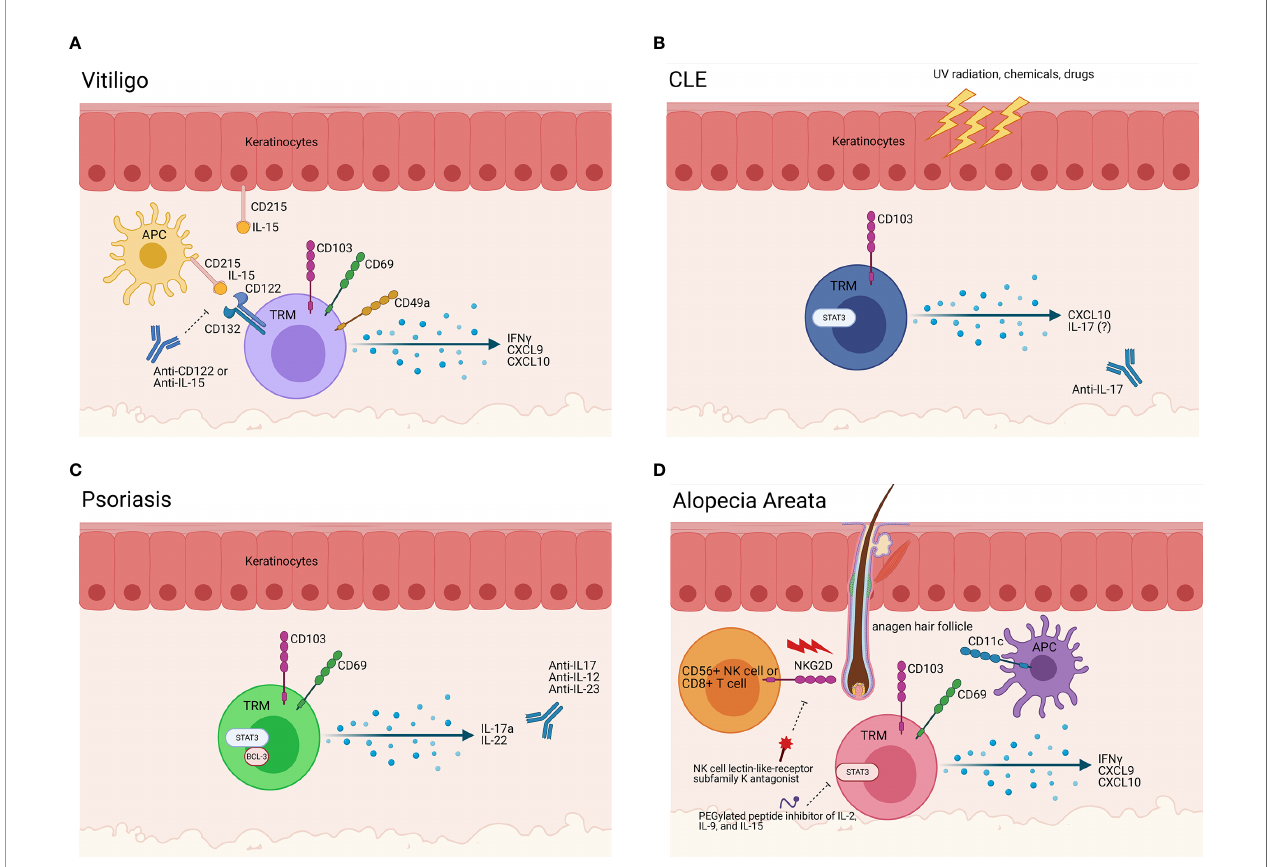
FIGURE 2 | Evidence of TRM in autoimmune skin disease. (A) TRM in vitiligo. Melanocyte-speci fi c TRM are present in vitiligo lesional skin. These cells express CD49a, CD69, CD103, and CD122 and produce IFN g and chemokines upon encountering cognate antigen, such as gp100/Pmel-17, melan-A/MART-1, tyrosinase and/or tyrosinase-related proteins 1 & 2 presented on HLA-A2. Antigen-presenting cells (APCs) and keratinocytes also play a role in vitiligo immunopathogenesis, as they release cytokines in response to a myriad of stimuli and stressors. APCs produce IL-15 and trans-present it on CD215 to T cells, which bear the CD122 and CD132 chains of the IL-15 receptor. In vitiligo, our data support that TRM act as sentinel/alarm cells to induce recall responses against melanocytes. Blocking CD122 deprives the TRM of the IL-15 survival signal, thereby inhibiting their function and/or reducing their numbers to provide a durable treatment. A clinical trial is currently enrolling to test the potential of a commercially available anti-IL-15 antibody for vitiligo (NCT04338581). (B) TRM cells in CLE. Triggers such as UV radiation, infection, hormones, drugs and chemicals create an apoptotic and in fl ammatory environment (50). In lupus-prone individuals, antigen-presenting cells (APCs) migrate to the site of injury and ingest the cell debris and possible autoantigens. When the APCs present the autoantigens to self-reactive T cells and B cells, the autoimmune response is initiated, and disease occurs (51). Speci fi cally, CD103+ TRM cells in the skin are positively correlated to disease severity and recurrence in patients. While TRM and T cell antigen speci fi cities in lupus nephritis were recently described (52, 53), speci fi cities of skin autoreactive T cells are unknown. A trial blocking anti-IL-17 antibody for DLE is recruiting (NCT03866317). (C) TRM cells in Psoriasis. CD69+ CD103+ TRM are present in psoriasis lesions. The production of cytokines such as IL-17a, IL-22, and Bcl-3 by these TRM cells lead to aberrant keratinocyte proliferation and differentiation. A recent study described melanocyte- speci fi c T cells in psoriasis patients, though other speci fi cities are unknown (54). Many trials for IL-17 family cytokine blockade, including IL-12/23, are